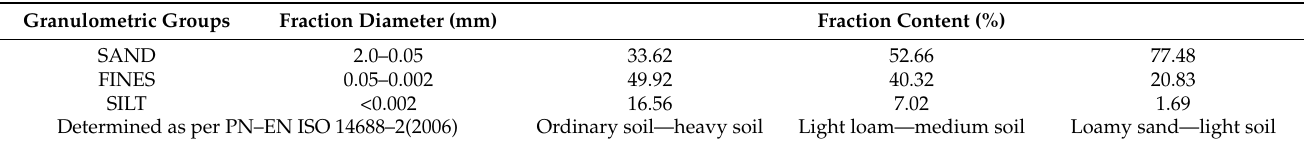
Table 1. Characteristics of soil abrasive mass.